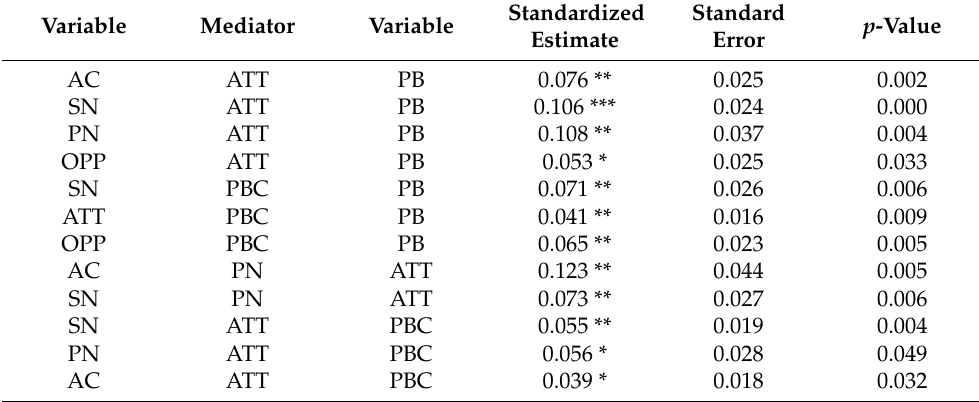
Table 6. Results of mediation